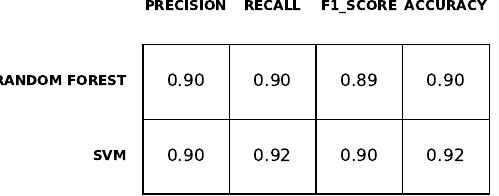
Figure 10. Results of the prediction of belief